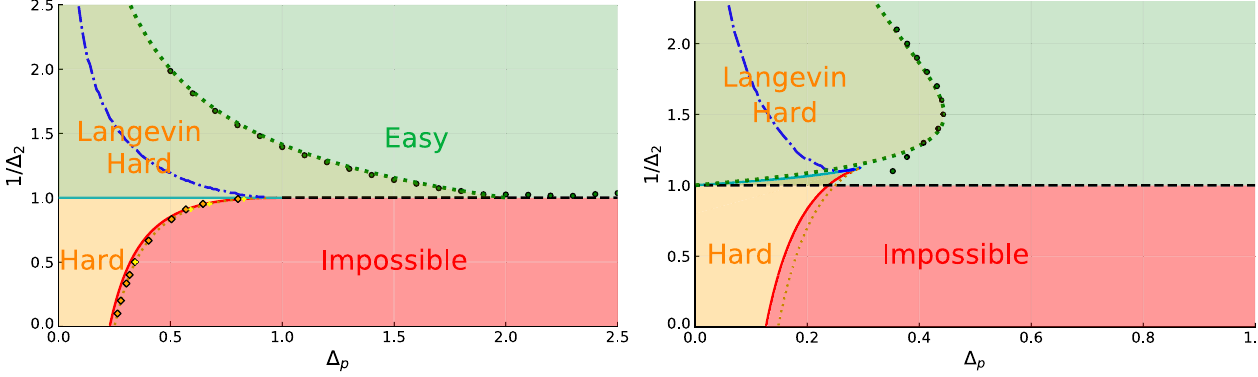
14. Left panel: Phase diagram of the spiked matrix-tensor model for p ¼ 3 as presented in the left panel of Fig. 7, with the additional boundary of the Langevin hard phase (green circles and dotted green line). The data points (circles) have been obtained numerically by fitting the relaxation time at fixed Δ and increasing Δ 2 . The green dotted line shows fixed points of expression (15). The p blue dashed-dotted line marks a region above which we no longer observe a stable positive 1RSB complexity. Finally, we plot with orange and yellow dots on the dynamical transition line as extracted from the relaxation time of the Langevin algorithm coming from the hard and impossible phases, respectively. Right panel: Phase diagram of the spiked matrix-tensor model for p ¼ 4 as presented in the right panel of Fig. 7 with the additional Langevin hard phase boundary. The data points are obtained by fixing Δ 2 and decreasing Δ . p Also in this case, we observe that the Langevin hard phase extends to the AMP easy phase. Interestingly, the Langevin hard phase here folds and presents a reentrant behavior; investigating the precise character of this reentrance is hampered by the vicinity of the critical point and is left for future work. The blue dashed line marks a region above which we no longer observe a stable positive 1RSB